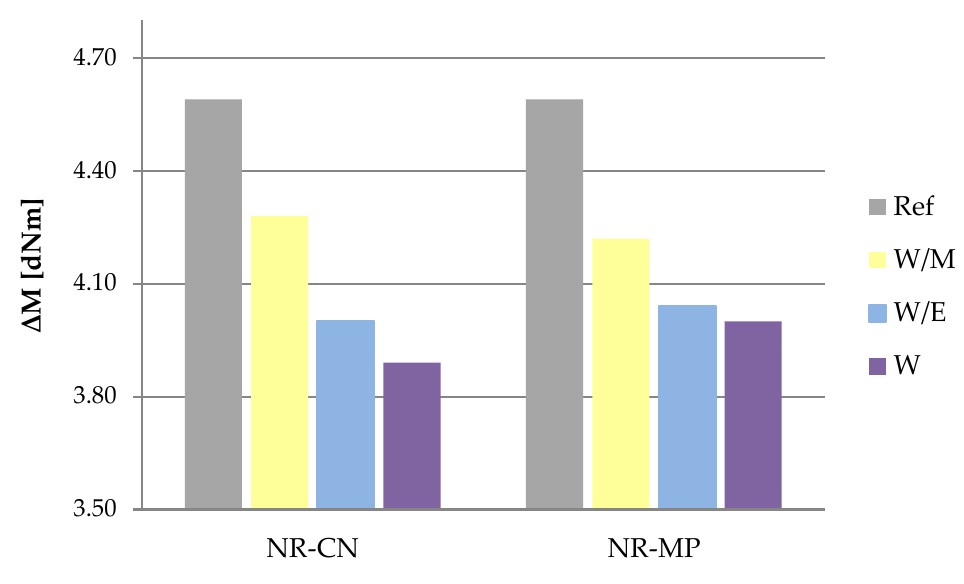
Figure 8. Increase in torque ( ∆ M).